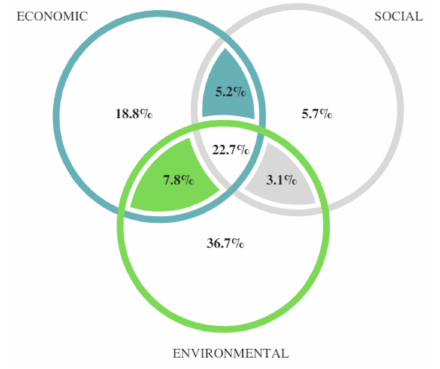
Figure 9. Venn diagram of the SD